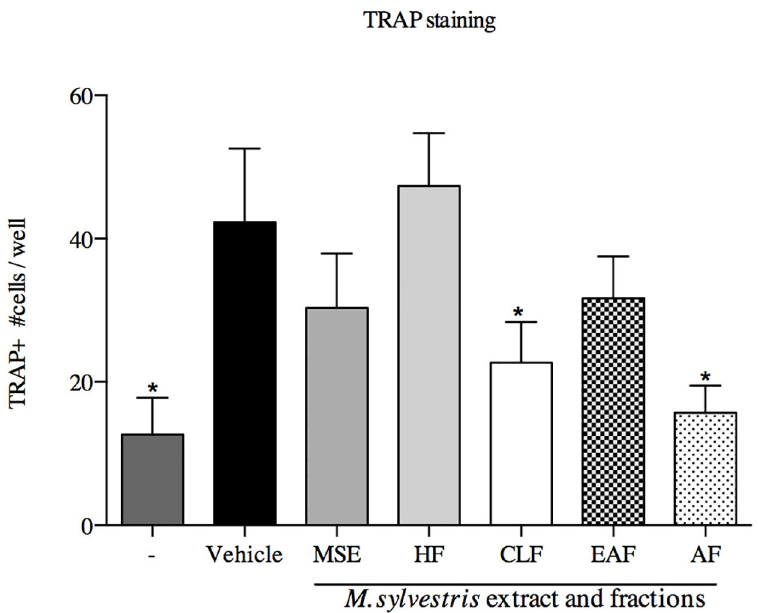
Fig 7. Activity of M . sylvestris and fractions in RANKL-mediated osteoclast differentiation. RAW 264.7 cells were stimulated with sRANKL (50 ng/ml) for 6 days. Cells were fixed and stained for TRAP. TRAP + multinuclear cells were counted. Data represent mean ± SD of three cultures. * p < 0.05; significantly lower than sRANKL-stimulated group.